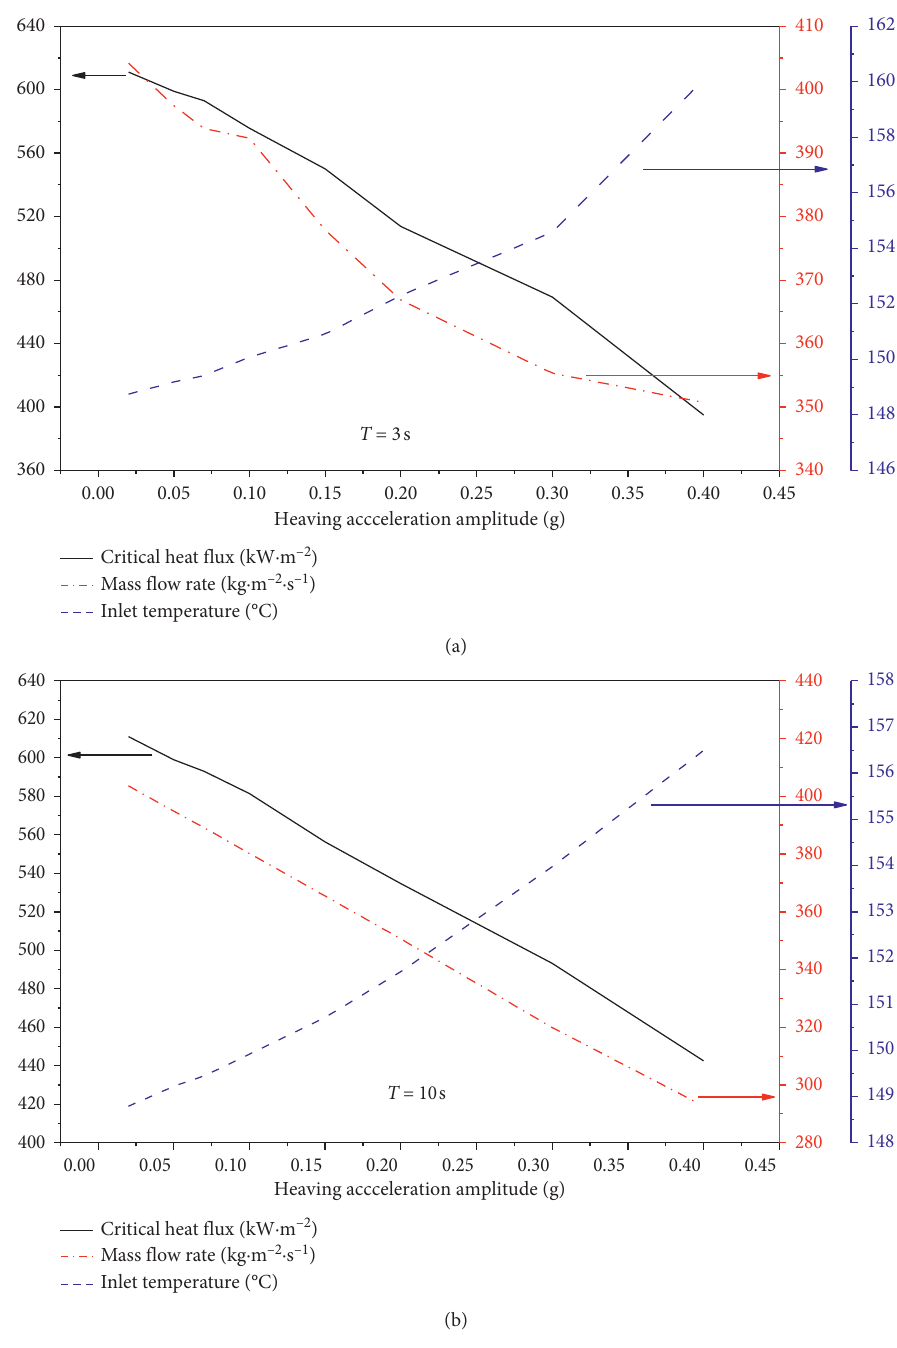
Figure 14: Influence of heaving acceleration amplitude on CHF. (a) T � 3s. (b) T � 10